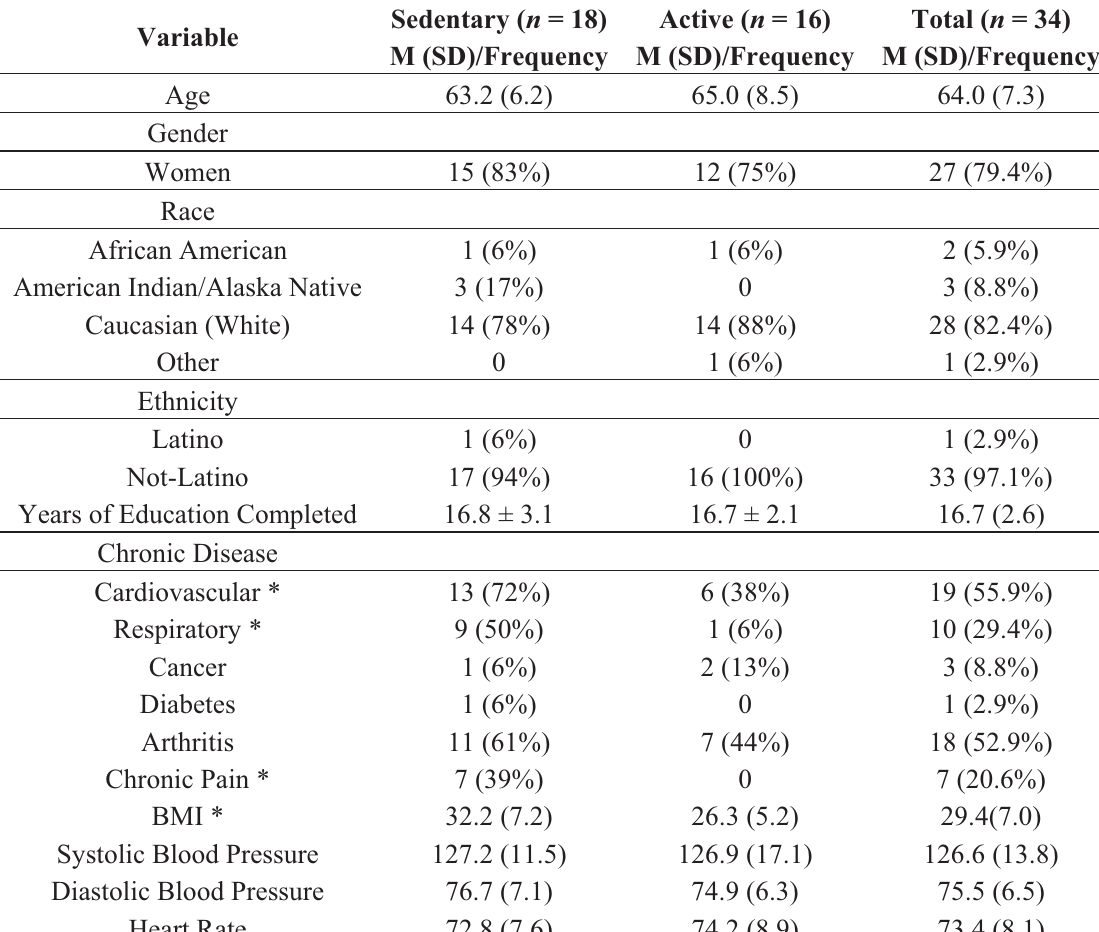
Table 2. Baseline Sample Characteristics ( N =